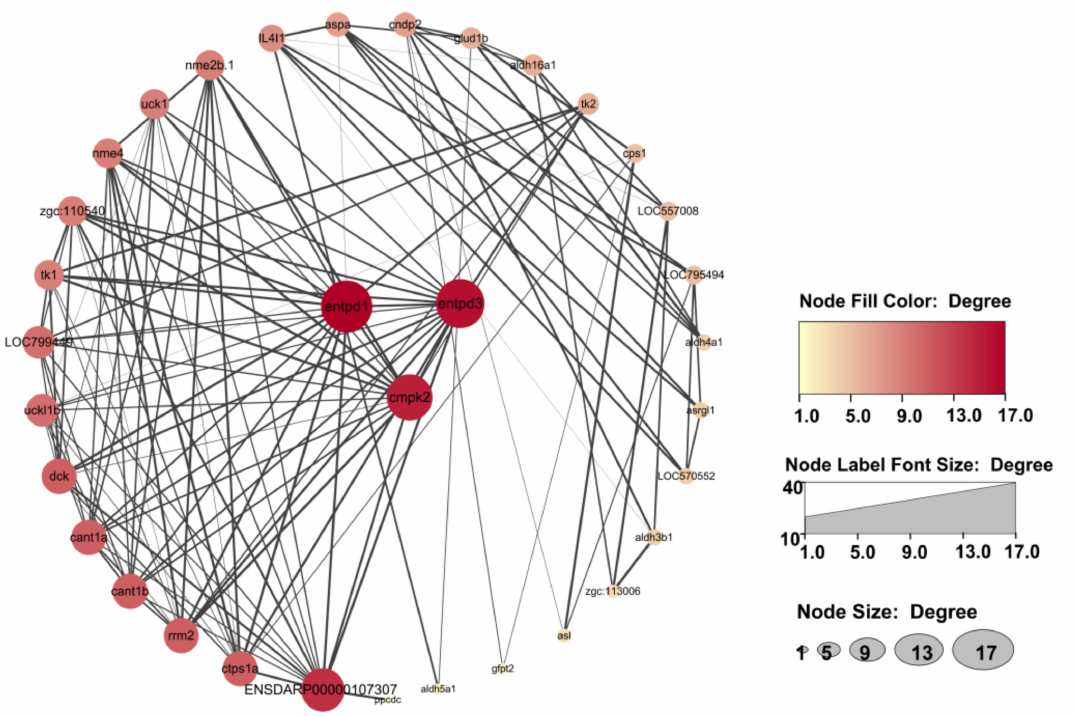
Figure 8. Protein–protein interaction network analysis of 35 differentially expressed genes in the four identified pathways. Entpd3 , entpd1 , and cmpk2 located in the center of the network are core